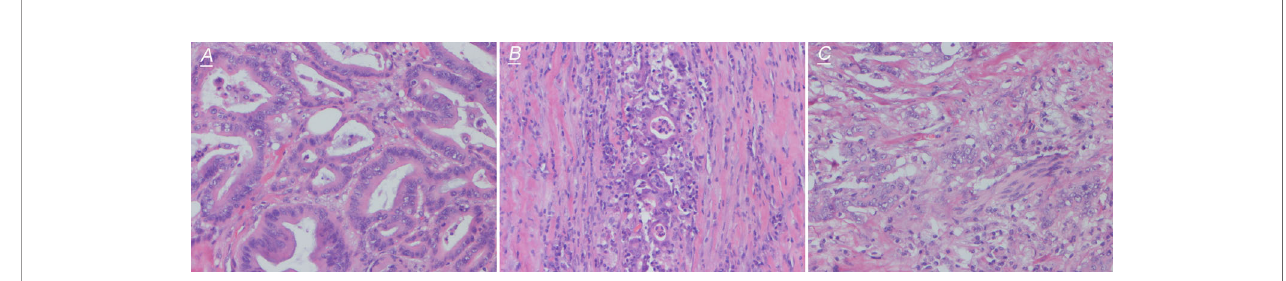
FIGURE 4 | Representative images of hematoxylin – eosin staining (200×) of NTRK effective fusion cases. (A) shows high differentiation, (B) shows medium differentiation, and (C) shows low